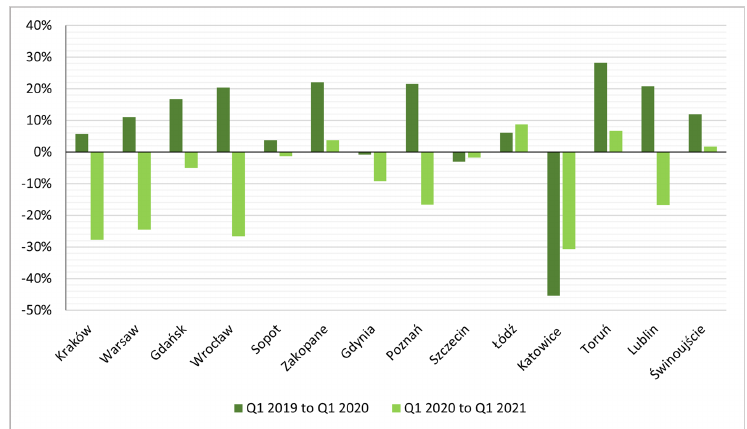
Figure 5. Indices of dynamics of changes, Q1 2019 to Q1 2020 and Q1 2020 to Q1 2021.